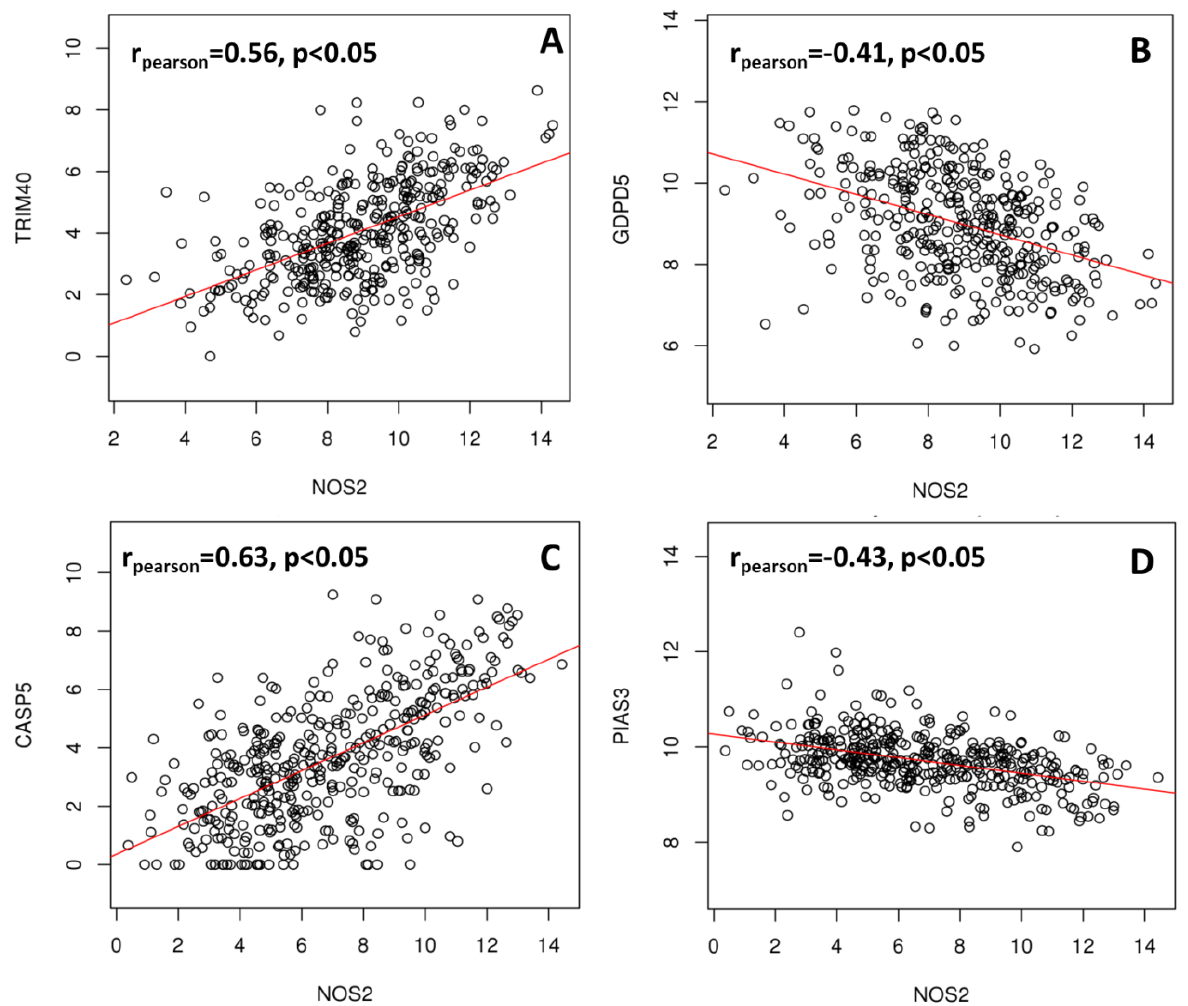
Figure 5: Pearson correlation analysis of the top positive and negative correlated genes with iNOS/NOS2(A: positive correlated genes with iNOS/NOS2 in colorectal cancer; B: negative correlated genes with iNOS/NOS2 in colorectal cancer; C: positive correlated genes with iNOS/ NOS2 in gastric cancer; D: negative correlated genes with iNOS/NOS2 in gastric